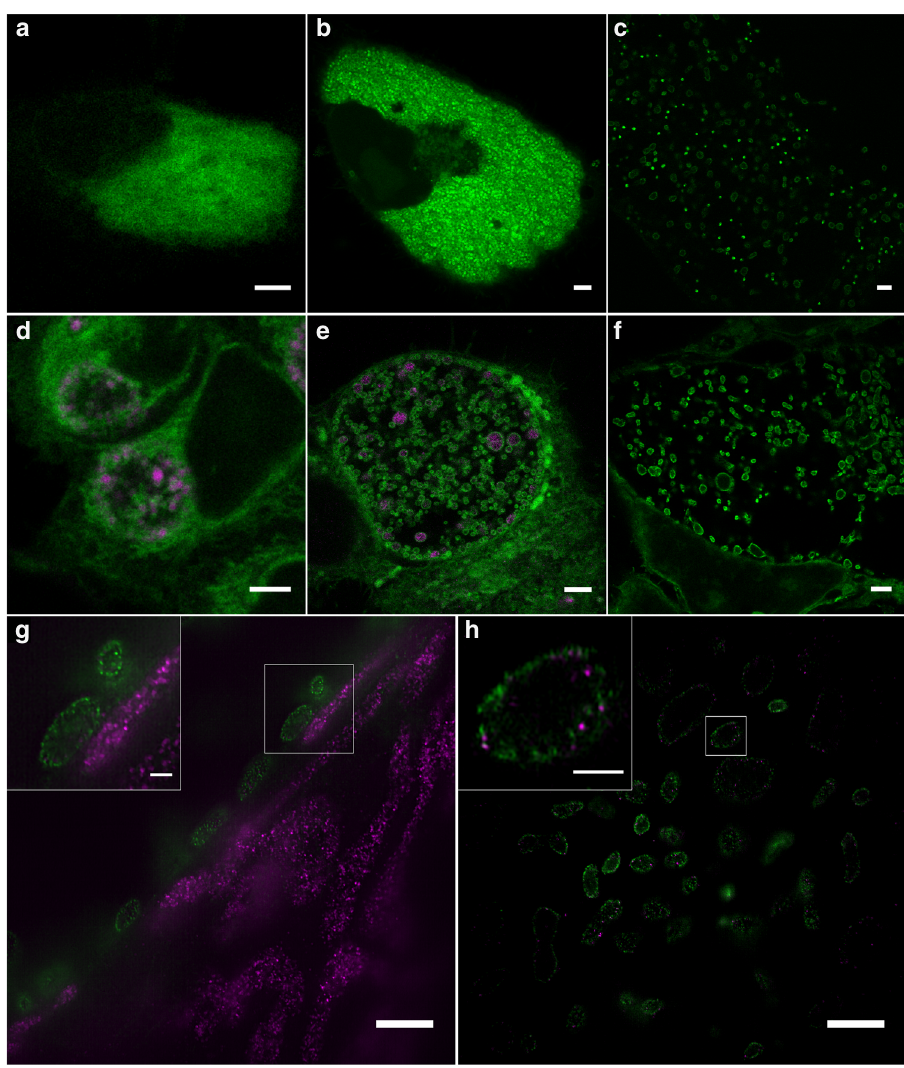
Fig. 3 Sphingolipid ExM visualizes intracellular pathogens and their interactions with mitochondrial proteins. a – c Cells were infected with Simkania negevensis for 96 h, fed with α -NH 2 - ω -N 3 -C 6 -ceramide, fi xed, permeabilized and stained with DBCO-Alexa Fluor 488 (green), and then imaged. The images show different cells before expansion ( a ), after 4x expansion ( b ), and 10x expansion ( c ) recorded by confocal microscopy. d – f Cells were infected with Chlamydia trachomatis for 24 h, fed with α -NH 2 - ω -N 3 -C 6 -ceramide, fi xed, permeabilized and stained with DBCO-Alexa Fluor 488 (green). Different cells were imaged before expansion ( d ), after 4x expansion ( e ), and 10x expansion ( f ) by confocal microscopy. In the unexpanded ( d ) and 4x expanded image ( e ) chlamydial HSP60 was immunolabeled with ATTO647N secondary antibody (magenta). g The mitochondrial marker protein Prx3 was stained by immunolabeling with an ATTO 647N secondary antibody (magenta). The confocal fl uorescence image of 10x expanded samples revealed a close contact between Chlamydia and mitochondria at the inclusion membrane. h SIM images of 10x expanded samples uncover that some Prx3 molecule are inserted into the bacterial membrane. The data were obtained from n = 3 independent experiments. Scale bars, 5 µ m (unexpanded images a , d ), 10 µ m (4x and 10x expanded images b , c , e , f , g , h ), and 2 µ m (magni fi ed views in images g , h